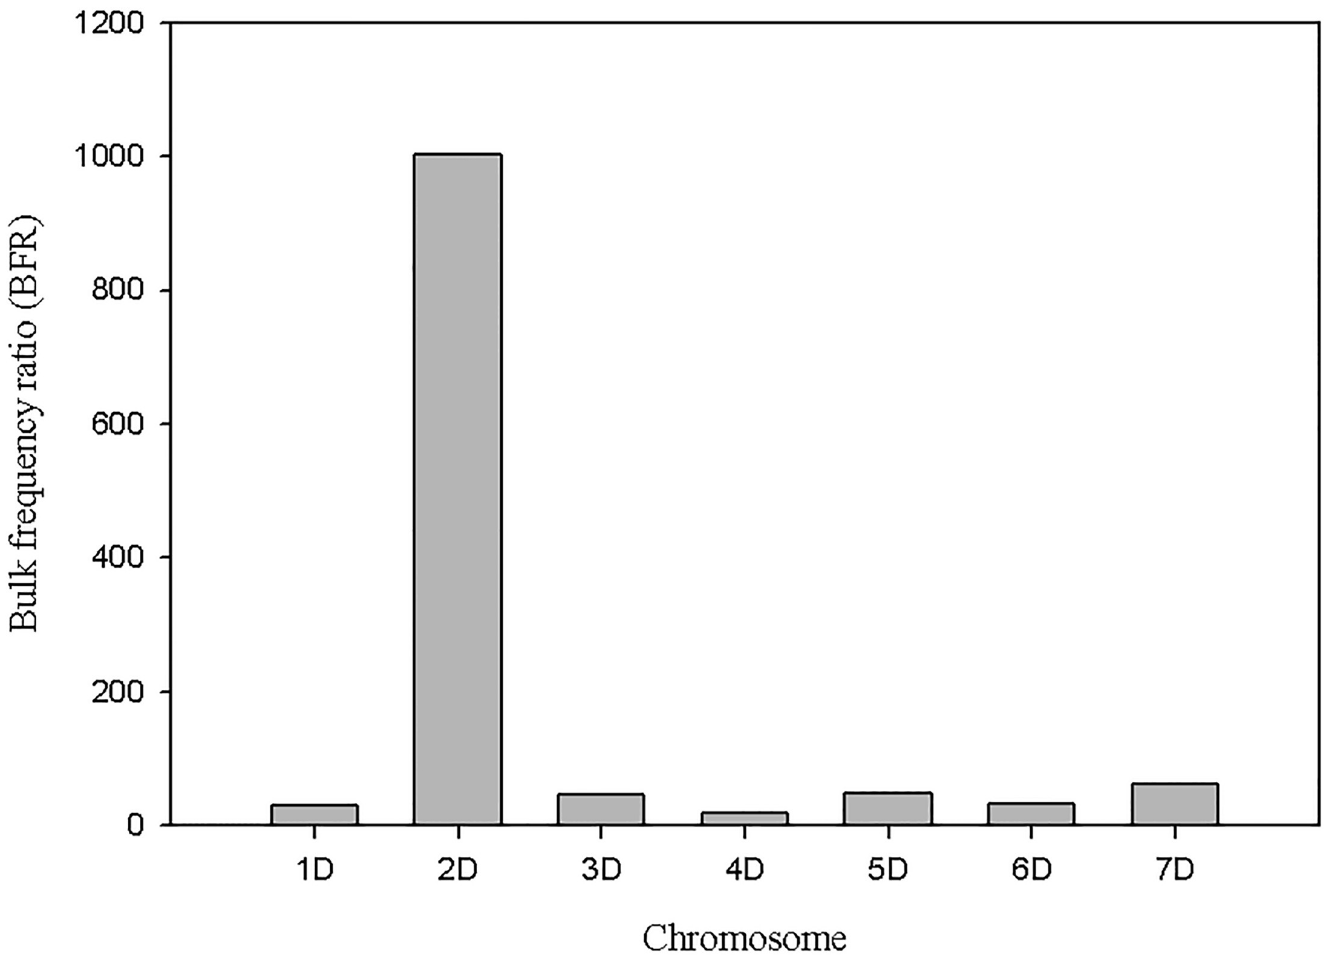
Fig 5. Distribution of SNPs with bulk frequency ratio higher than 4 on Ae . tauschii chromosomes.